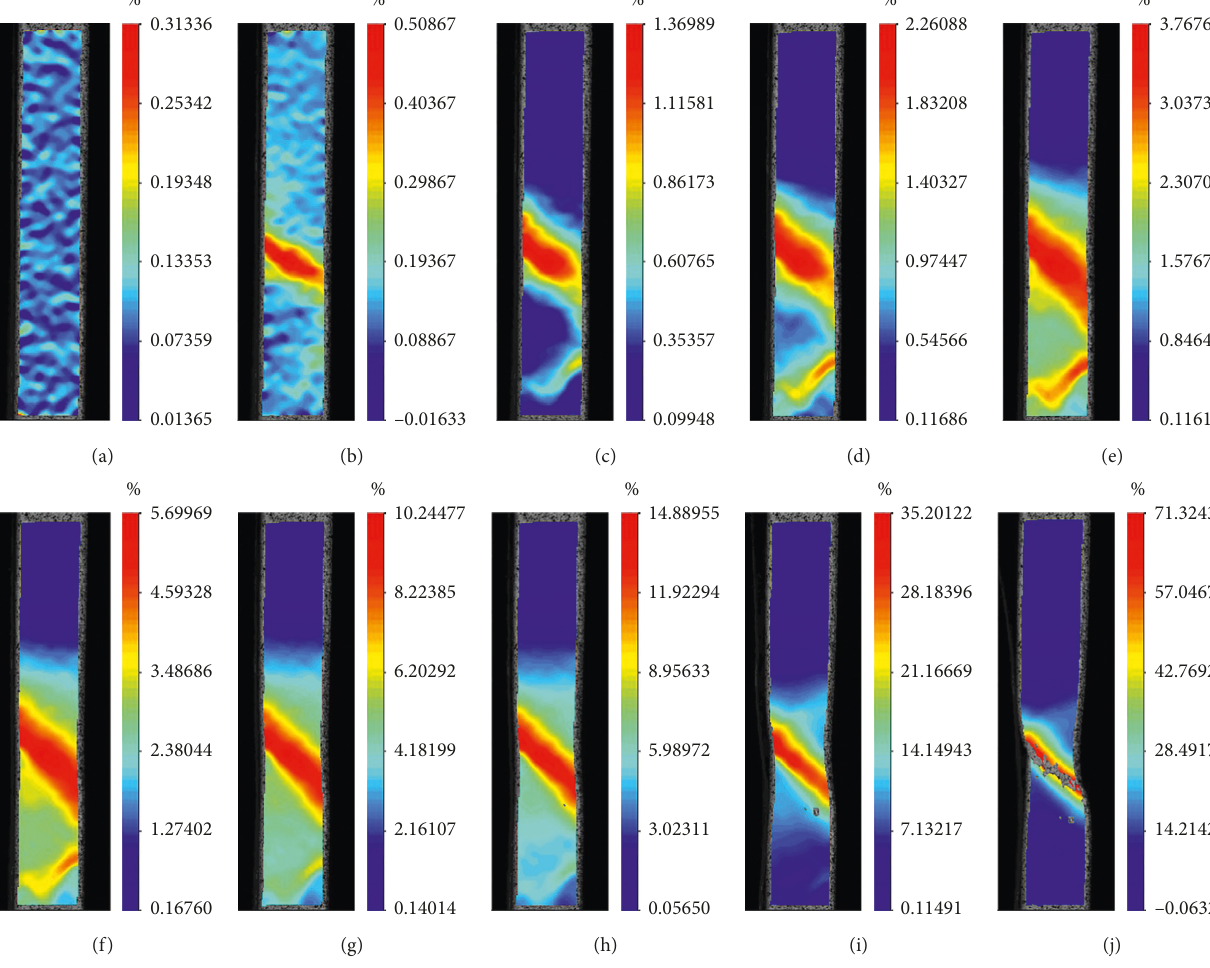
Figure 4: The strain field evolution of the weld region of Sample 1 monitored by DIC.